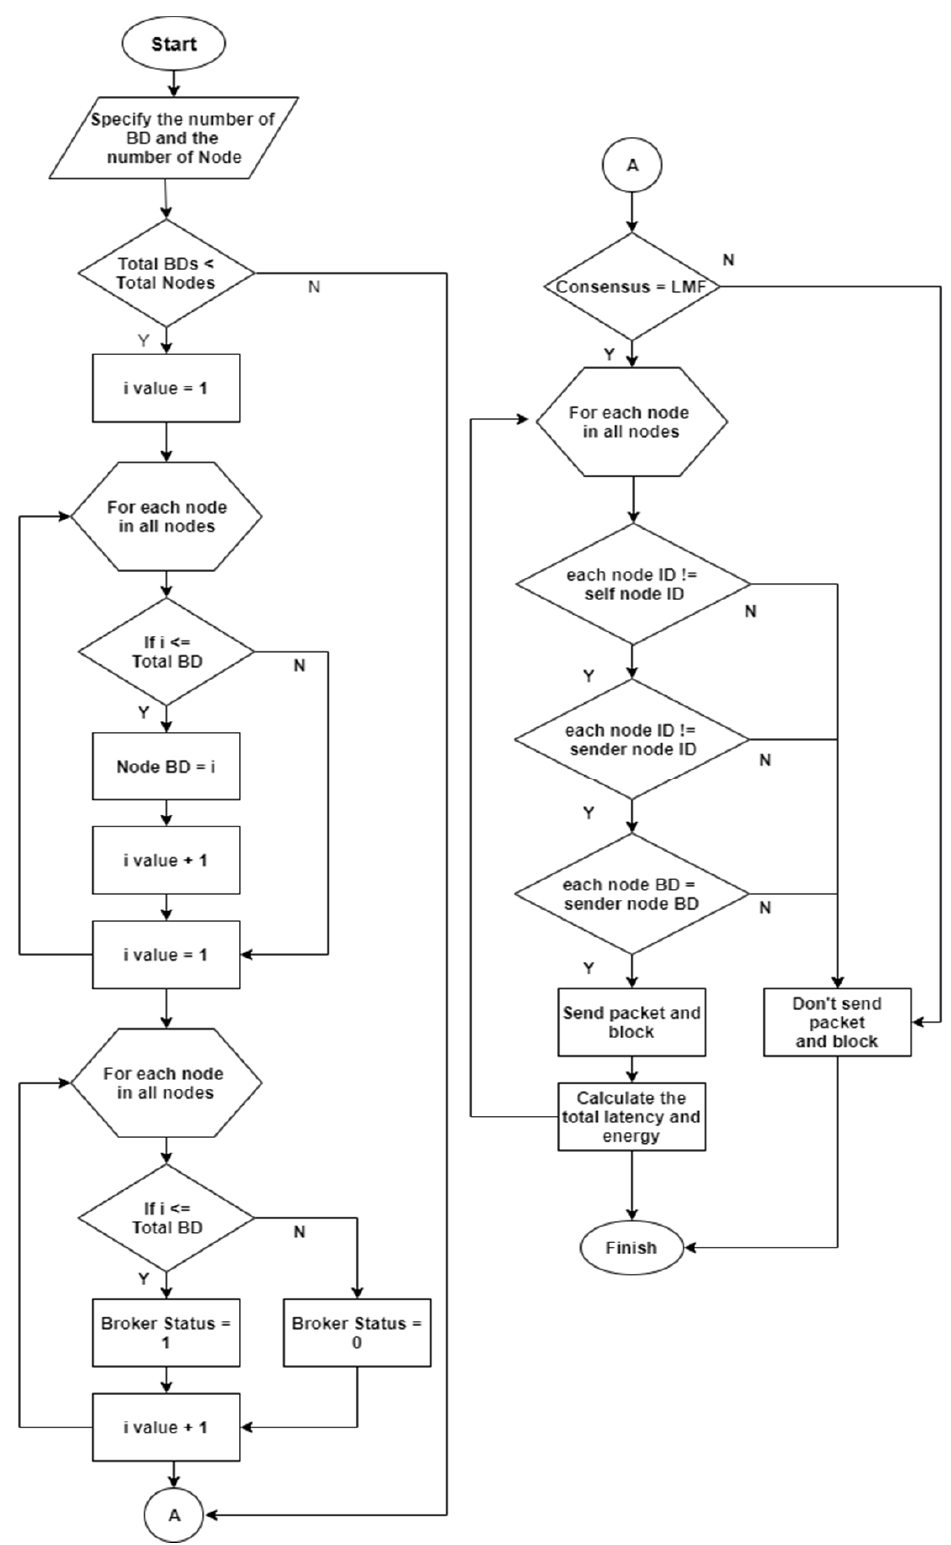
Figure 7. Flow distribution of Broadcast Domain (BD) and transmission on BD.